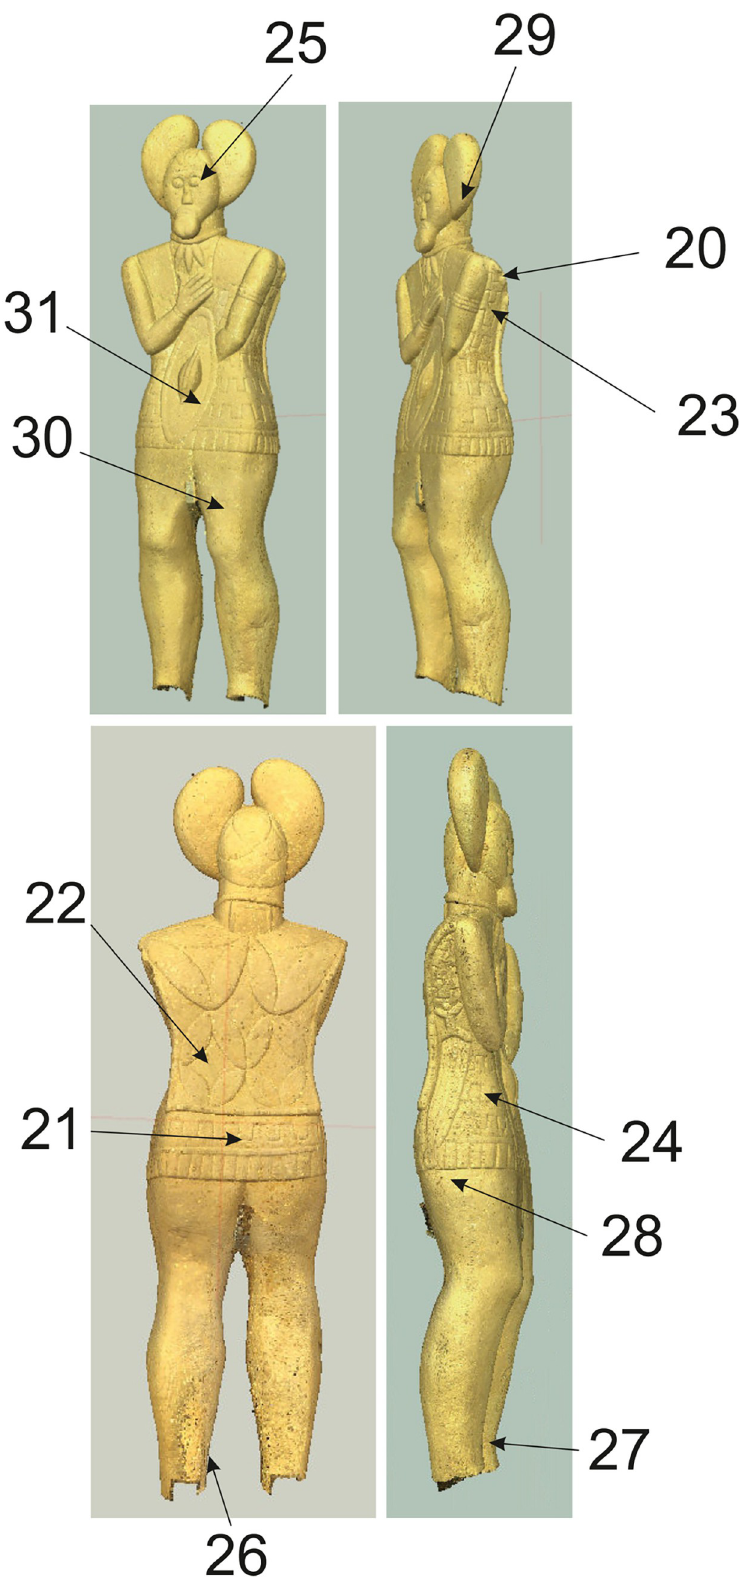
Fig 22. Points of the X-ray fluorescence measurements (author: M. Cihla and F. R. Va´clavı´k). https://doi.org/10.1371/journal.pone.0271353.g022 PLOS ONE | https://doi.org/10.1371/journal.pone.0271353 August 11,